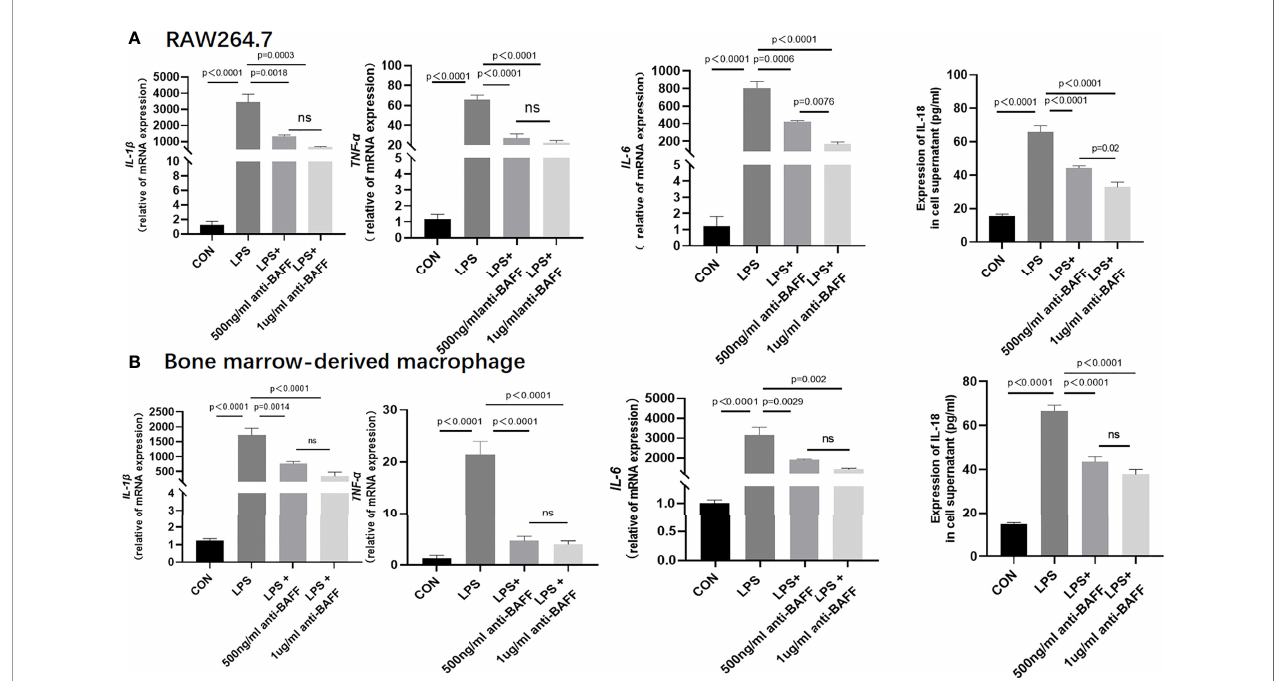
FIGURE 7 | Anti-BAFF antibody plays an anti-in fl ammatory role in RAW 264.7 cell and BMDM. (A) RAW 264.7 cells were intervened with mouse anti-BAFF antibody or mouse immunoglobulin G1 (IgG1) isotype control antibody at 500 ng/ml or 1 ug/ml in the presence of LPS 1 ug/ml for 6 (h) The mRNA level of IL-1 b , TNF- a , and IL-6 was measured by RT-qPCR, IL-18 was measured in cell supernatant by ELISA. (B) Bone Marrow Derived Macrophages were obtained and were treated with mouse anti-BAFF antibody at 500 ng/ml or 1 ug/ml in the presence of LPS 1 ug/ml for 6 h, pulsed with ATP (2 mM, Sigma Aldrich, USA) for 30 min. The mRNA level of IL-1 b , TNF- a and IL-6 was measured by RT-qPCR, IL-18 was measured in cell supernatant by ELISA. ns, P > 0.05.